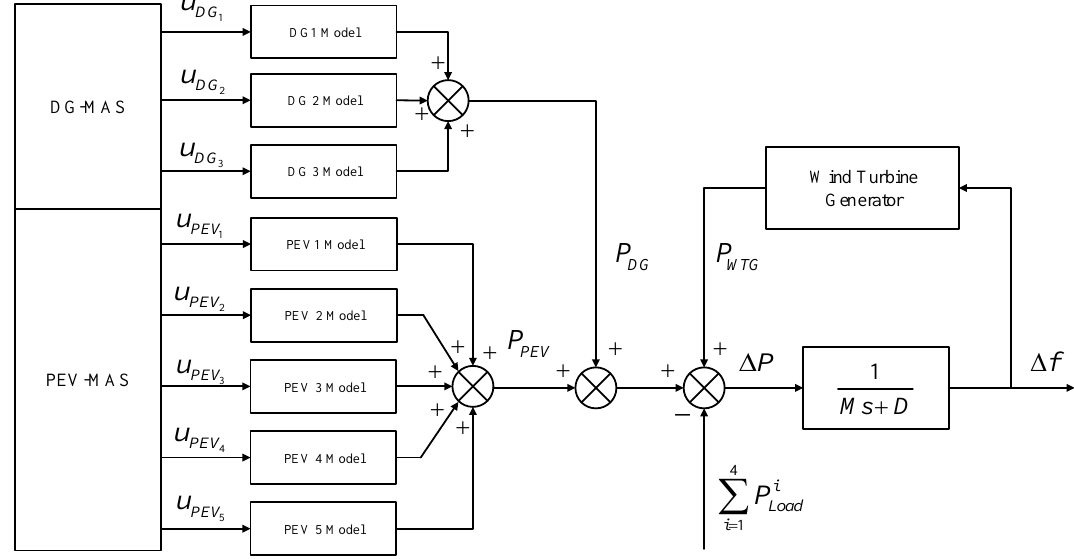
Figure 8. Control strategy of microgrid frequency regulation. Multi-agent system (MAS), multi-agent